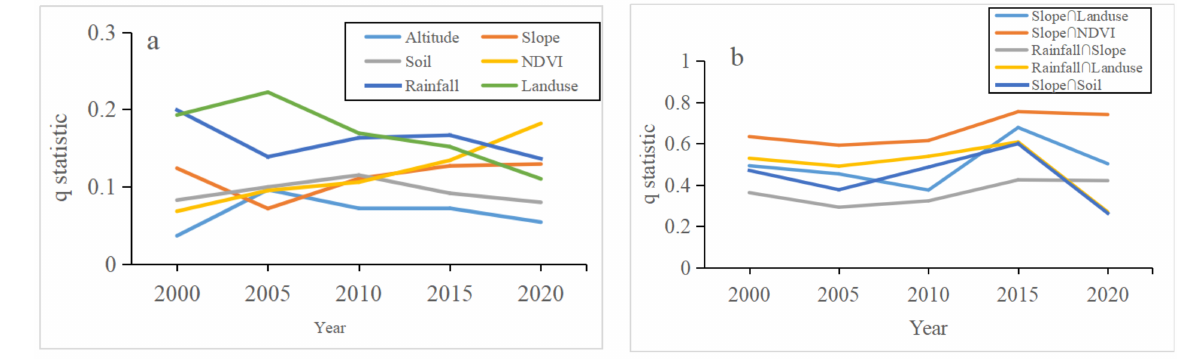
Figure 4. The q values of influencing factors on soil erosion from 2000 to 2020 (( a ) q statistic; ( b ) interaction q